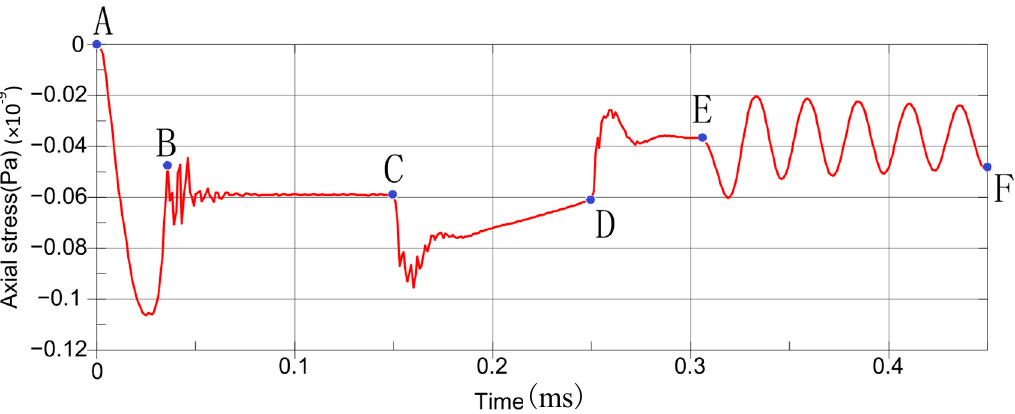
Figure 14. The relation of axial stress-time curves of piezoelectric sheet at 260 °C .